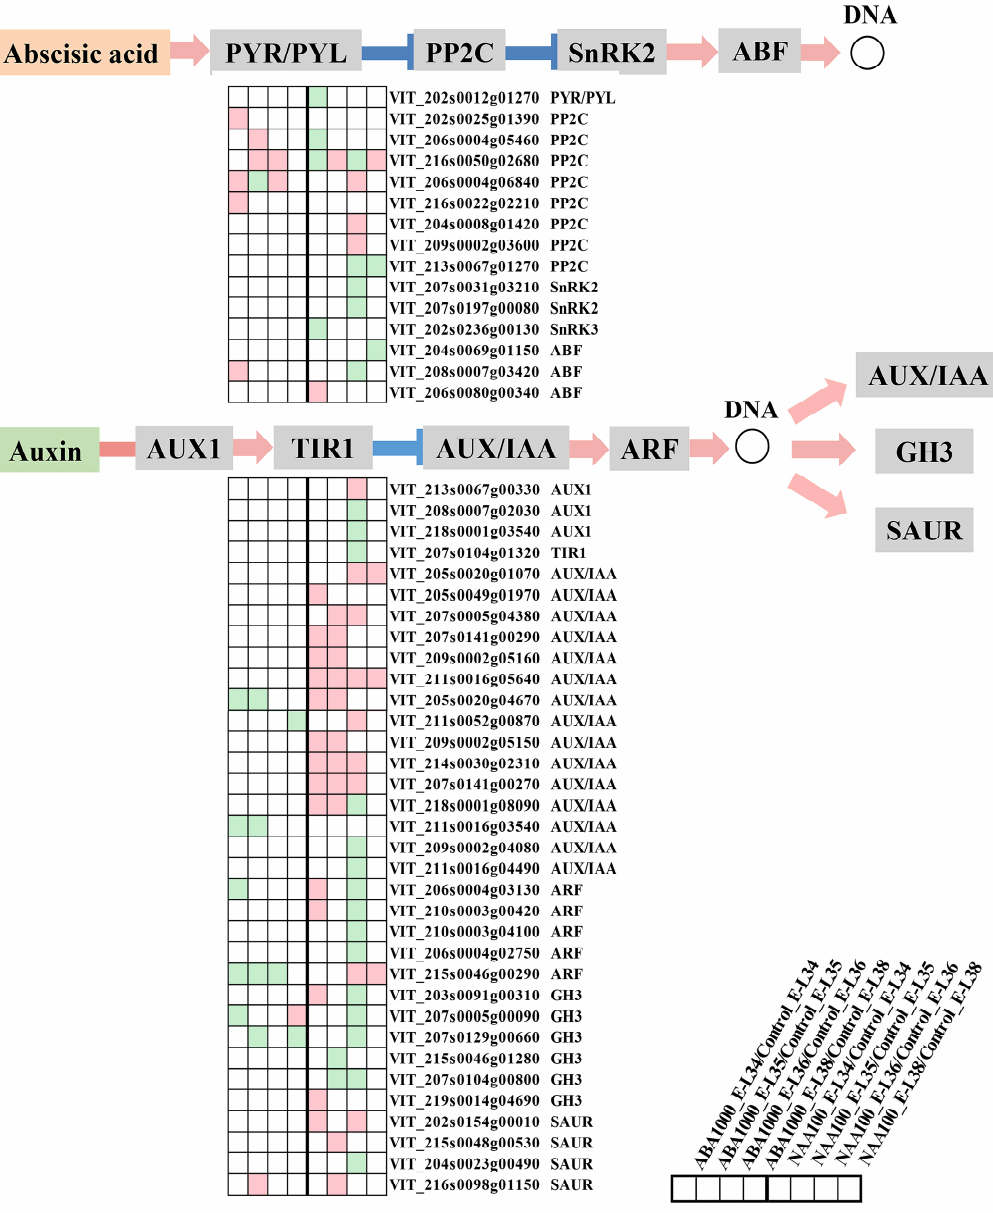
Figure 3. Expression of genes involved in ABA and auxin signaling pathway. Green and cyan boxes represent significantly downregulated and upregulated genes, respectively, in treated berries compared to the control.